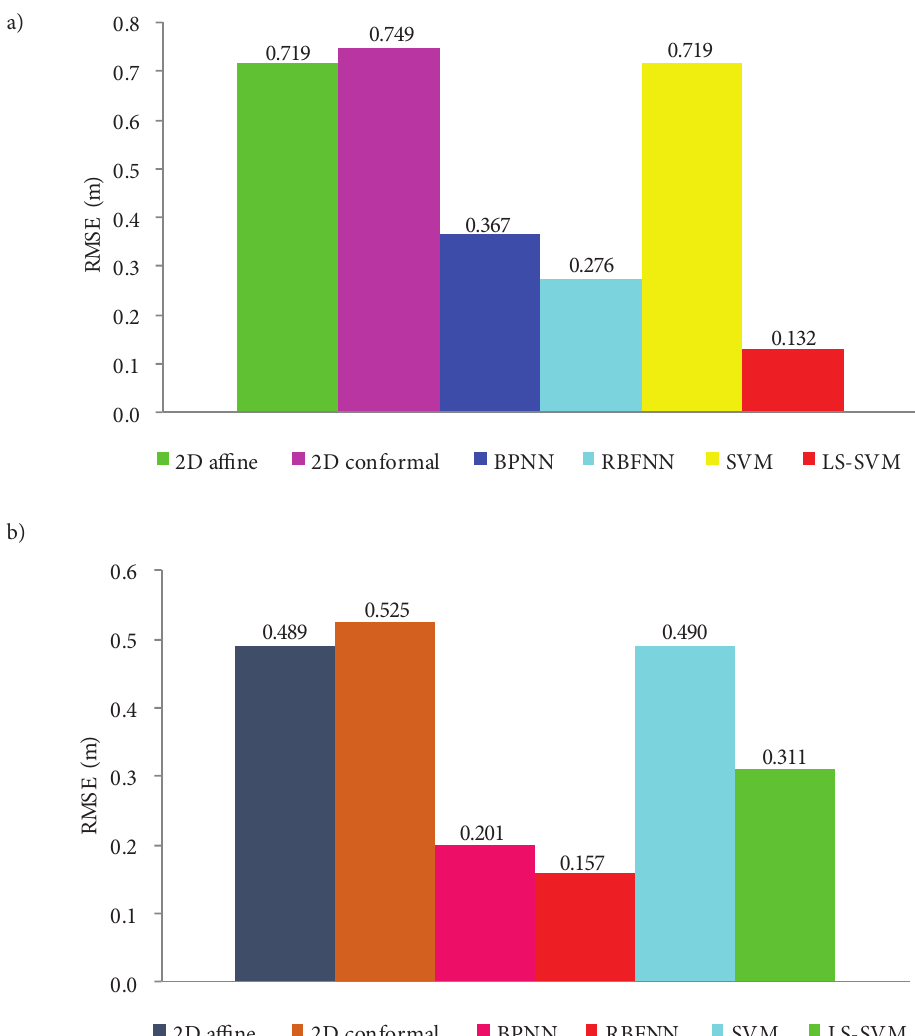
Figure 4. RMSE results of the methods based on the testing data for (a) Easting and (b) Northing